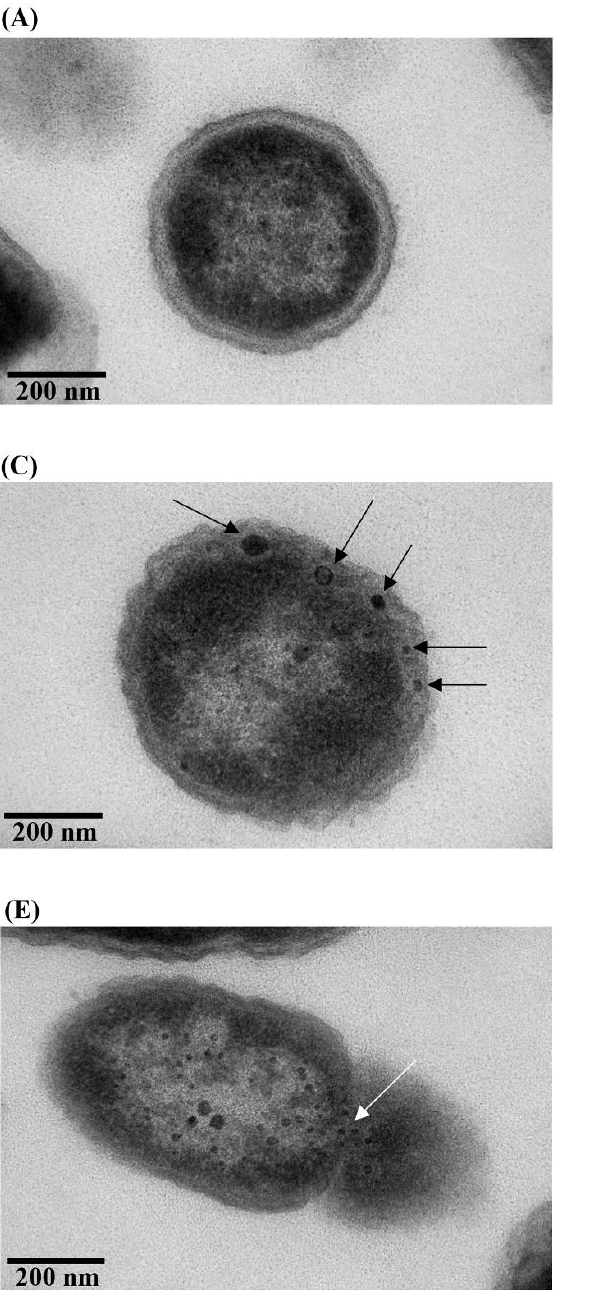
Figure 7. TEM micrographs of treated and untreated P . aeruginosa TISTR 357 . ( A ) Untreated and ( B – F ) Col - AgNP - treated cells in multiple stages, covering the attachment, penetration, membrane disruption, and cell lysis